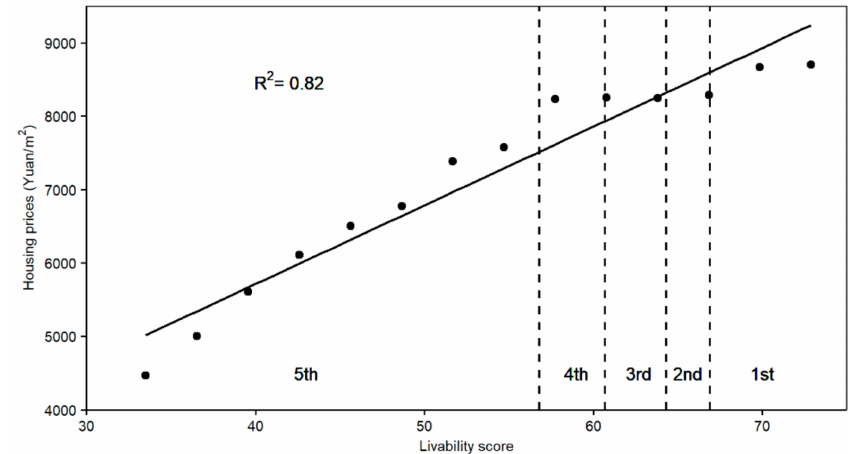
Figure 12. Relationship between housing prices and livability scores. Housing prices show a significantly positive correlation with livability scores ( p <